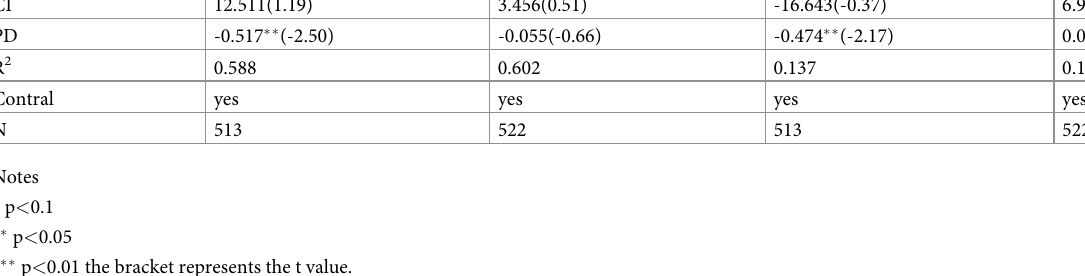
column (21) and (22) are listed as the regression results of OIS to low income and high-income groups. The results show that in the regression of OIS, no matter in the high-income group or the low-income group, DIF has a positive effect on IT. However, the regression coefficient for the low-income group is 0.235, which is significant at the 1% significance level. The regression coefficient of the high-income group is 0.210, and the influence coefficient of the high-income group is lower than the influence coefficient of the low-income group. This is because the resources in low-income areas tend to be depleted, and the original resource-based industries are not enough to maintain development. Therefore, the promotion of DIF in low-income cit- ies is more likely to stimulate the development of the service industry. The results in columns (23) and (24) show the regression results of industrial rationalization on the low-income and high-income groups. Since most high-income cities are coastal cities with convenient trans- portation and natural trade conditions, they form abundant capital deposit. With the develop- ment advantages, industrial transformation in high-income cities is reasonable, and it is easier to restrain the development of extractive industries. Therefore, DIF has a greater impact on IT in high-income group than in low income group.